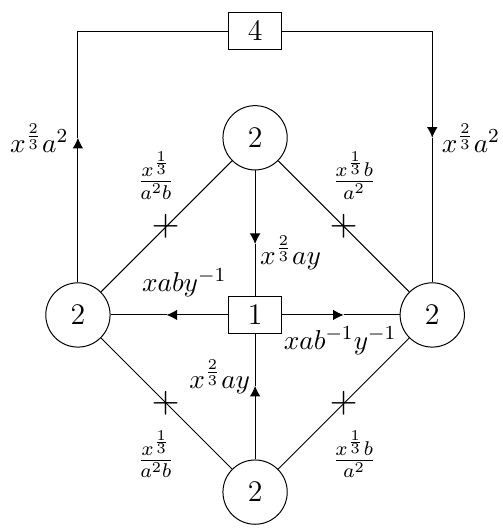
Figure 10 . The 3 d quiver theory associated with the compactification of the 5 d E 6 SCFT on a √ torus with flux ( 3; 1 , 0 , 0 , 0 , 0) . There are Chern-Simons terms of levels ( 1 also contains cubic superpotential interactions associated with the four triangles, and the flipping superpotentials. Additionally, there are two quartic superpotential involving the bifundamentals charged under the global SU(4) group with the upper and lower semi-circles, and four monopole superpotential of the type (1 , 1) for all adjacent SU(2) groups, properly dressed by SU(2) × SU(2) bifundamentals to form a gauge